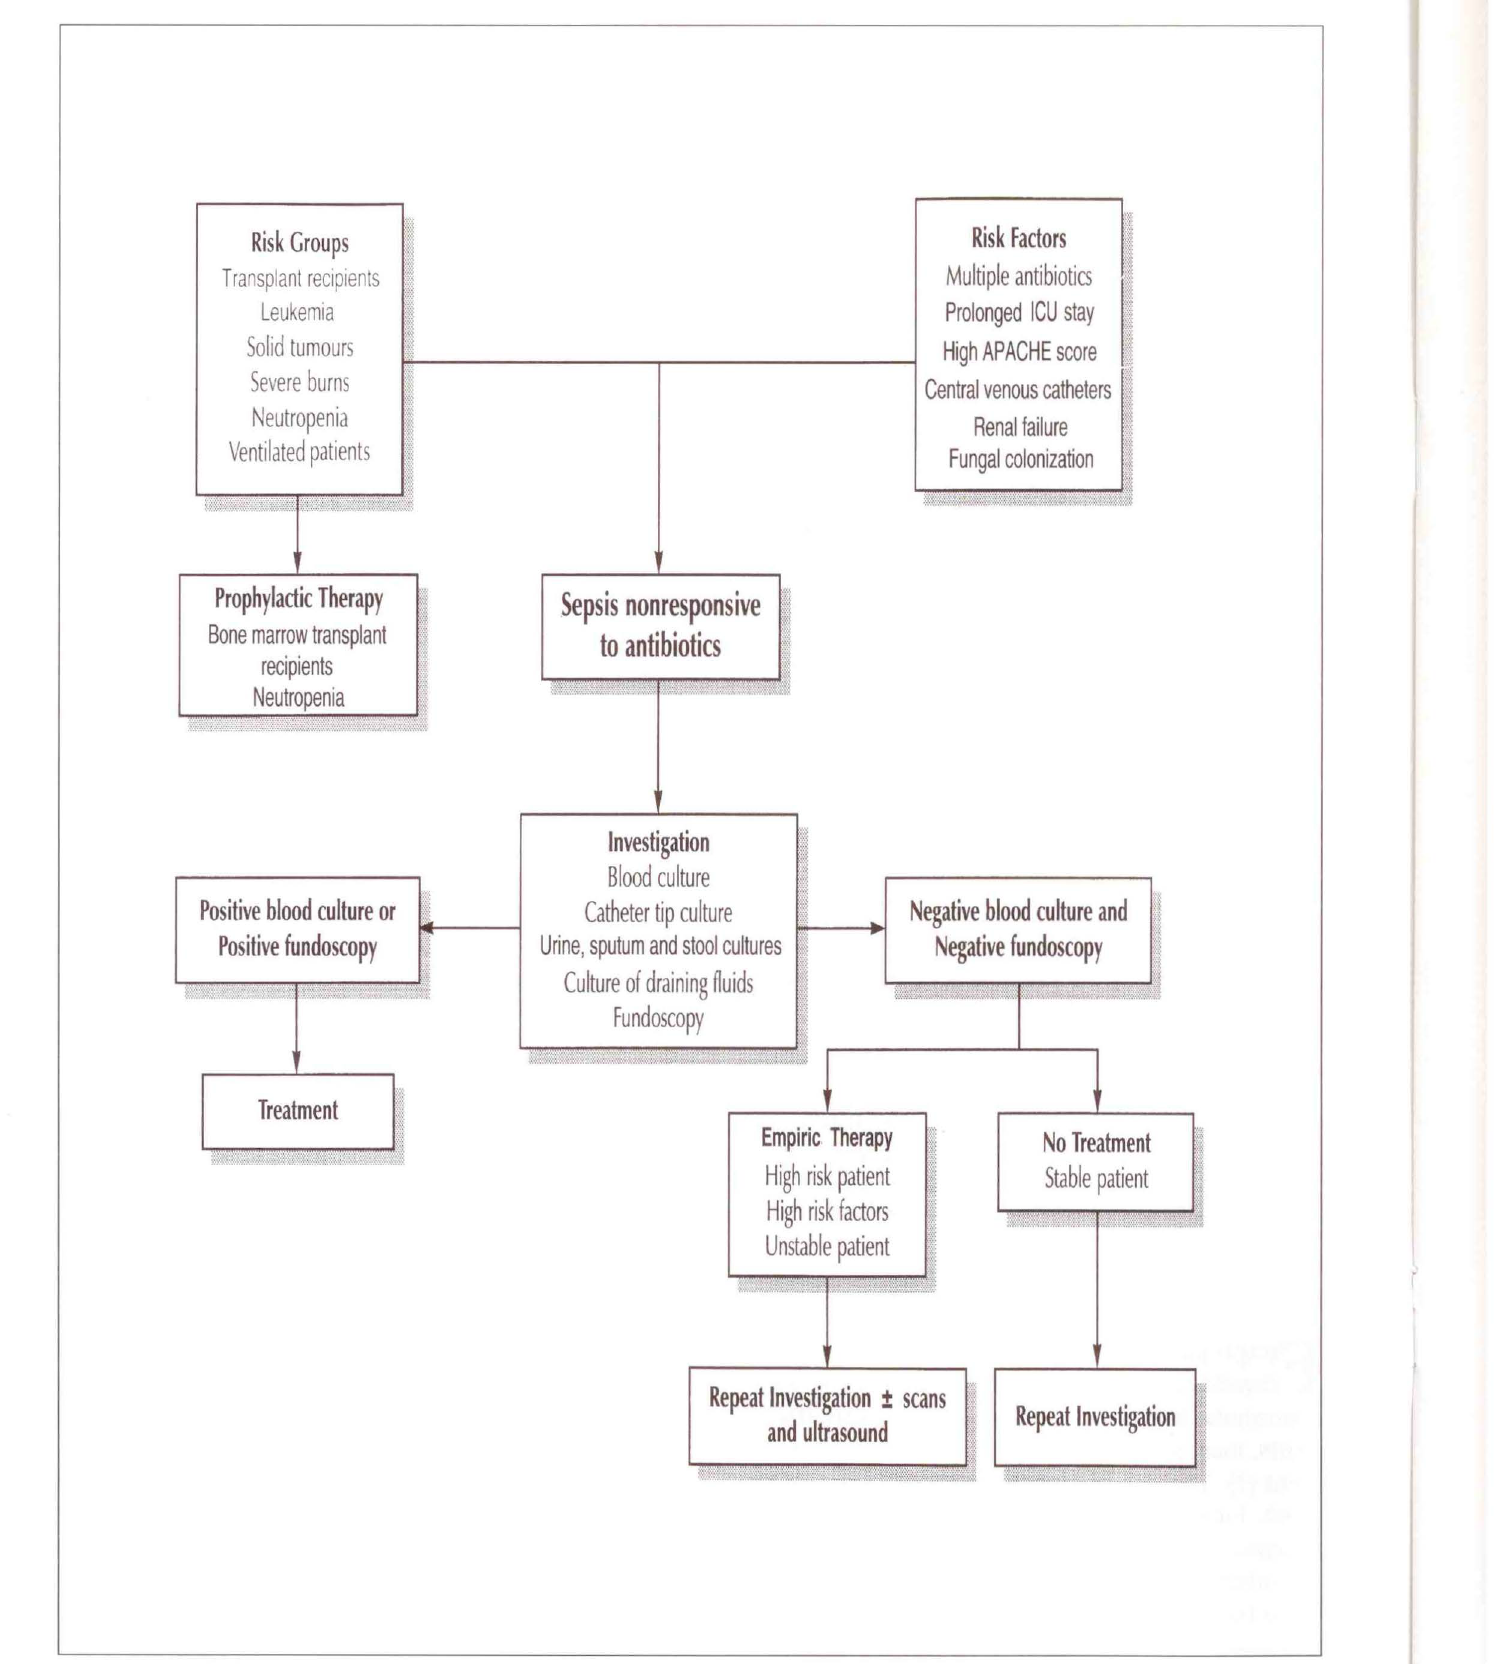
Figure 1) A therapeutic algorithmJor intensive care unit (ICU) patients at riskJorcandidiasis. APACHE Acute Physiologic Score and Chronic Health